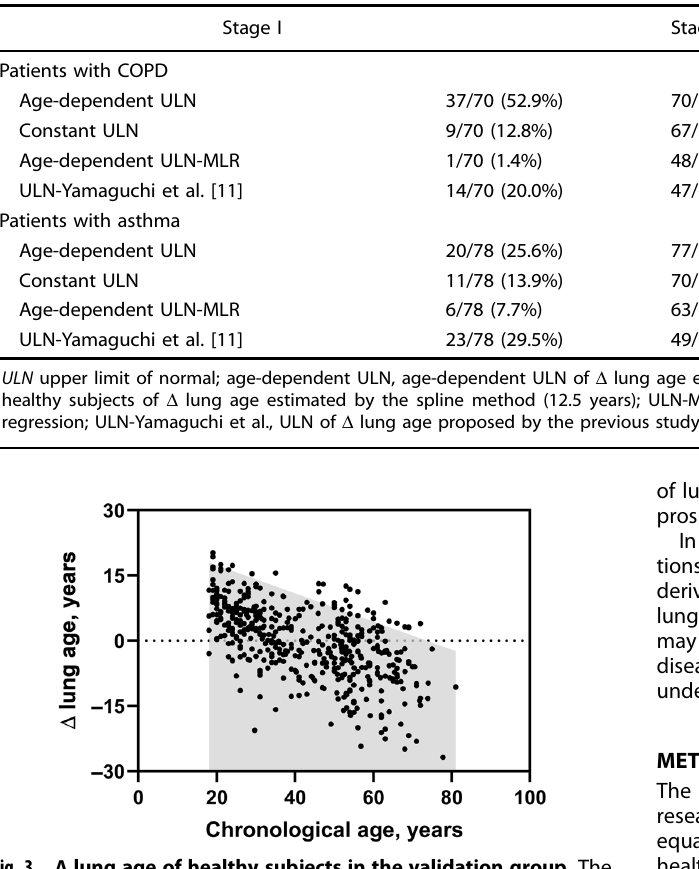
Table 5. Number (percentage) of patients with Δ lung age over the